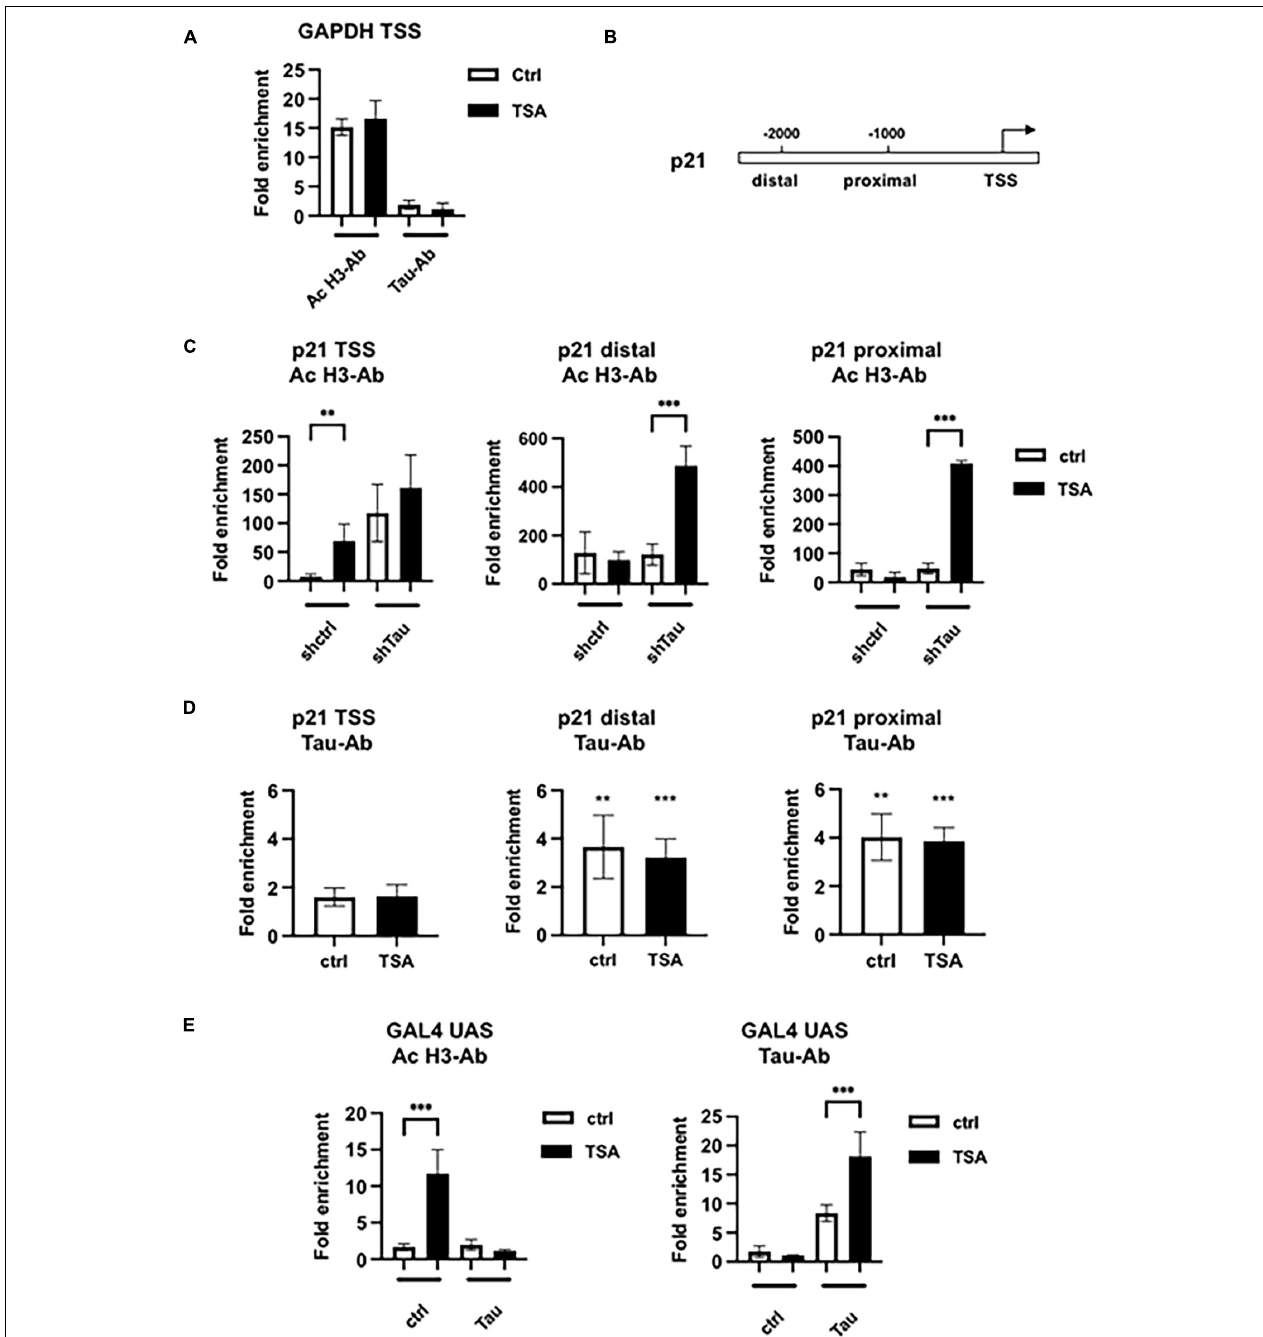
FIGURE 3 | Histone H3 acetylation and Tau occupancy at different promoters. (A) Chromatin immunoprecipitations-qPCR analysis of H3 acetylation and Tau occupancy on the GAPDH promoter in MCF7shctrl cells in the indicated conditions. MCF7shctrl cells were subjected to cross-linking by 1% formaldehyde. Chromatin fragments were then immunoprecipitated using antibodies (Ab) against acetylated H3 (ac-H3) or Tau and analyzed by quantitative PCR for the presence of the GAPDH promoter. Quantification of enrichment is represented as fold-enrichment relative to IgG. (B) Functional organization of the p21 promoter. (C) ChIP-qPCR analysis of H3 acetylation in MCF7shctrl or shTau cells or (D) Tau occupancy in MCF7shctrl cells on the p21 promoter. Quantification of enrichment is represented as fold-enrichment relative to IgG. Data are mean ± SD over IgG control, ∗ * P < 0.01, *** P < 0.001. (E) ChIP-qPCR analysis of H3 acetylation or Tau occupancy on the stably transfected GAL4UAS responsive luciferase reporter transfected, or not, with Tau4R, then 24 h later treated with 100 nM TSA for 24 h. Cells were then subjected to cross-linking by 1% formaldehyde. Chromatin fragments were then immunoprecipitated using antibodies (Ab) against acetylated H3 or Tau and analyzed by quantitative PCR for the presence of the GAL4 UAS promoter. Quantification of enrichment is represented as fold-enrichment relative to IgG. Data are mean ± SD, ∗ * P < 0.01, *** P < 0.001.